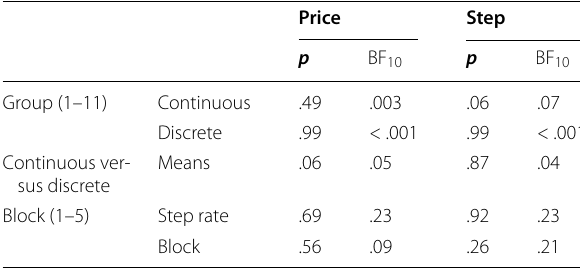
Table 1 Experiment 1 results summary